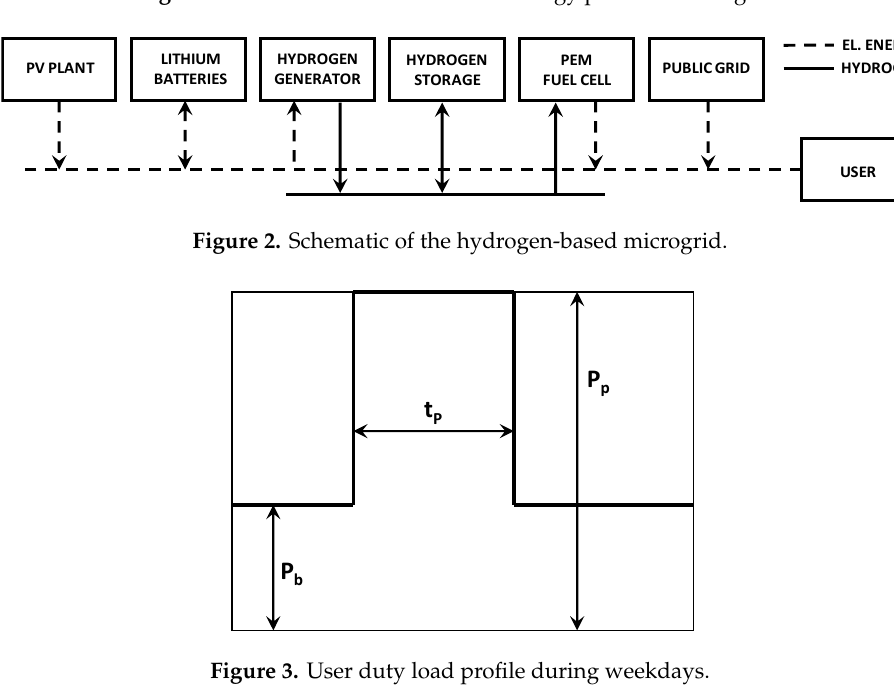
Figure 1. Schematic of the renewable energy platform microgrid.